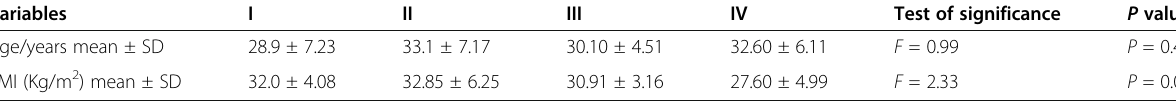
Table 1 Age and BMI of control group and studied cases